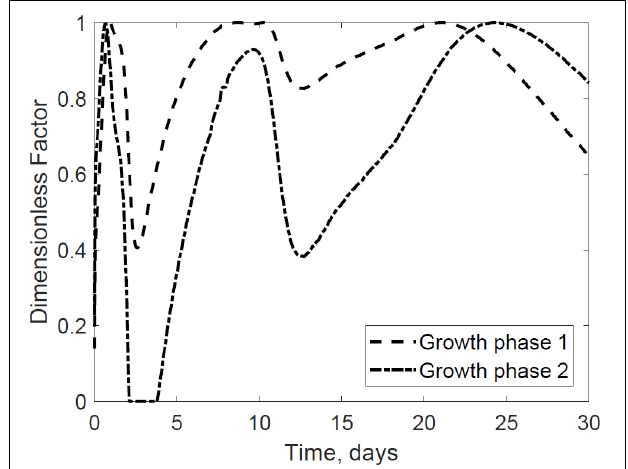
FIGURE 6 | Dynamic response of microbial activity due to variations in the thermal system. The environmental temperature (dimensionless) factor represent ideal conditions for growth and organic matter loss as a value of 1. Values of zero represent inhibiting conditions that reduce microbial growth and dry matter loss. The model describes how environmental factors change through time.